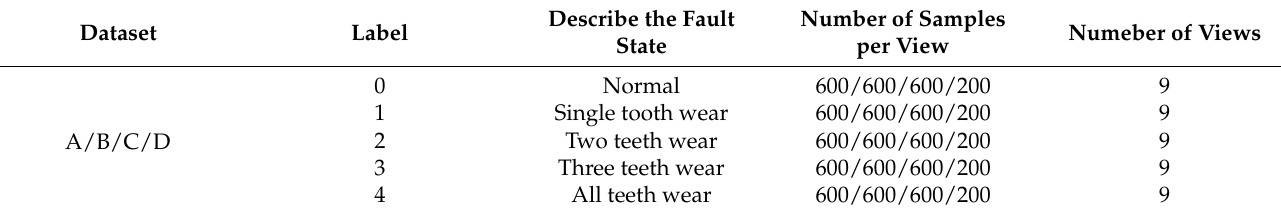
Figure 5. Raw vibration signals of five health states of planetary gearbox collected by multi-sensors at 1500 rotation speed. Table 2. The training set and test set at different